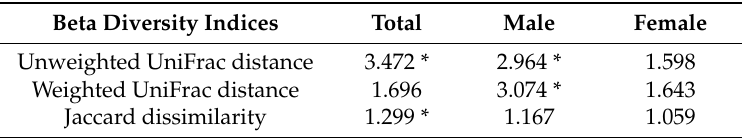
Table 2. The statistical significances of beta diversity distances from lower three quartiles groups based on different measurement methods.